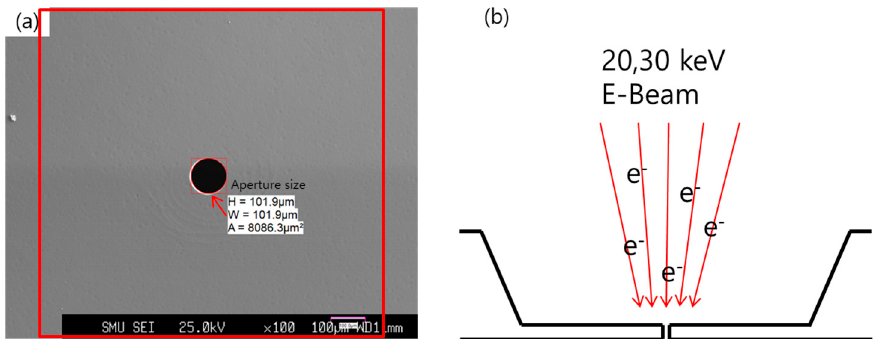
Figure 7. ( a ) SEM image showing a × 100 magnification of the aperture hole of an electron lens (red box: 1 mm × 1 mm area irradiated with an electron beam). ( b ) Cross-sectional schematic diagram of an electron beam irradiated onto the aperture hole of the Si electron lens.